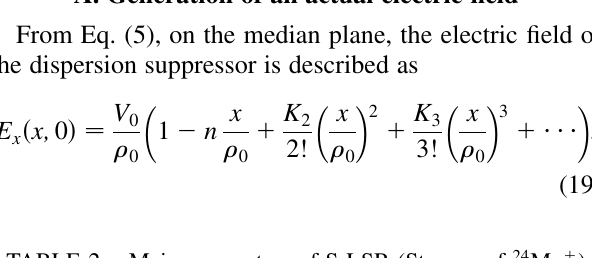
TABLE 2. Main parameters of S-LSR (Storage of 24 Mg (cid:2) ) Quantity Value Cooled ion species 24 Mg (cid:2) Kinetic beam energy 35 keV Ring circumference 22.557 m Radius of curvature at the bending section 1.05 m